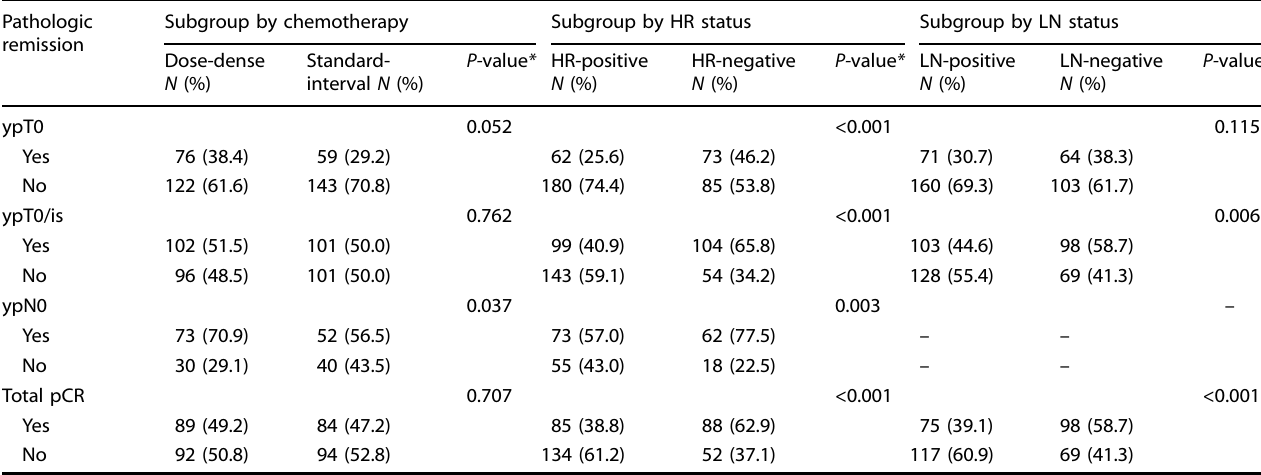
Table 2. Pathologic complete responses by